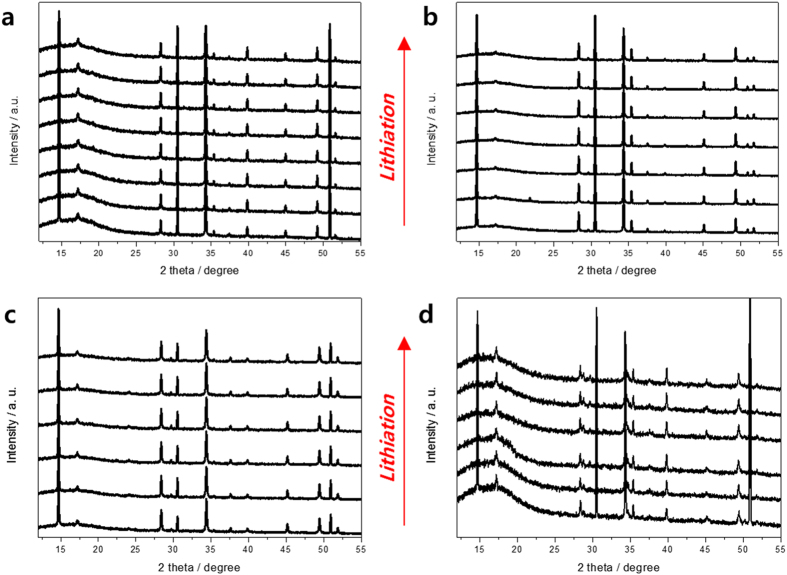
In-situ XRD patterns of Li4−x/3Ti5−2x/3CrxO12 (a) x = 0 (b) x = 1 (c) x = 2, and (d) x = 3 during lithiation process.